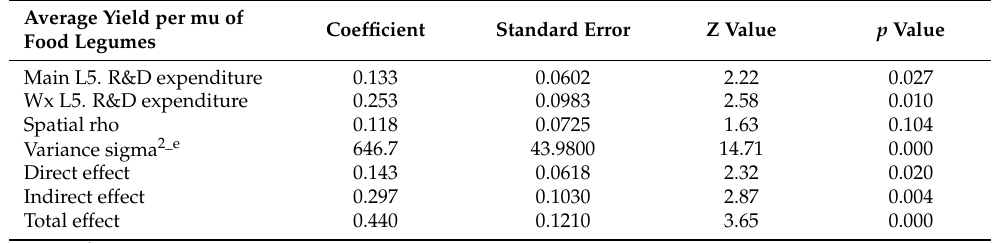
Table 3. SDM estimation of average yield per mu of food legumes in 31 provinces from 2002–2020. Average Yield per mu of Food